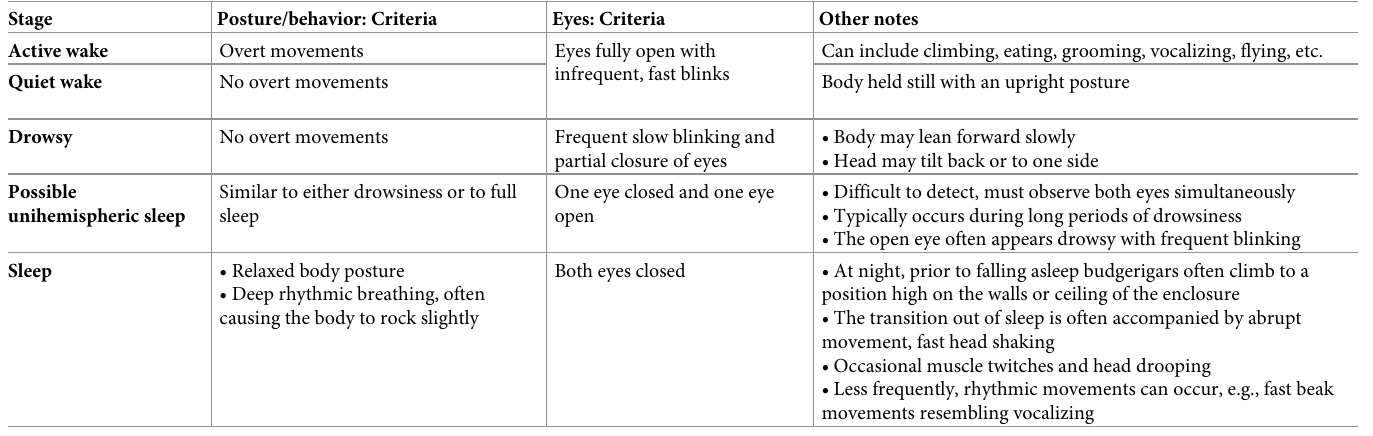
Table 3. Behavioral scoring